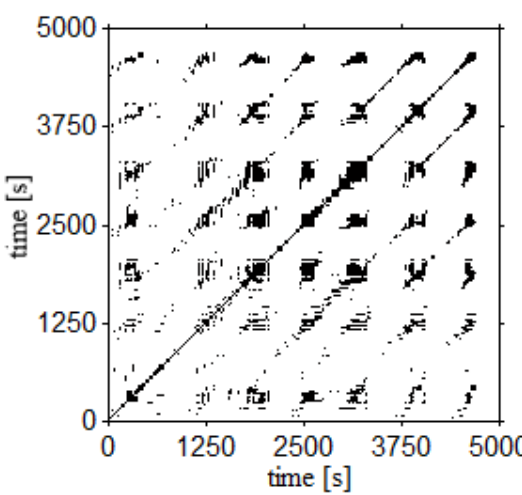
Figure 4. Recurrence plot of pressure fluctuations in the period of time between 101–106 s for m = 4, τ = 100, ε = 0.8 σ . The calculations have been made using the CRP toolbox for Matlab ® [27].